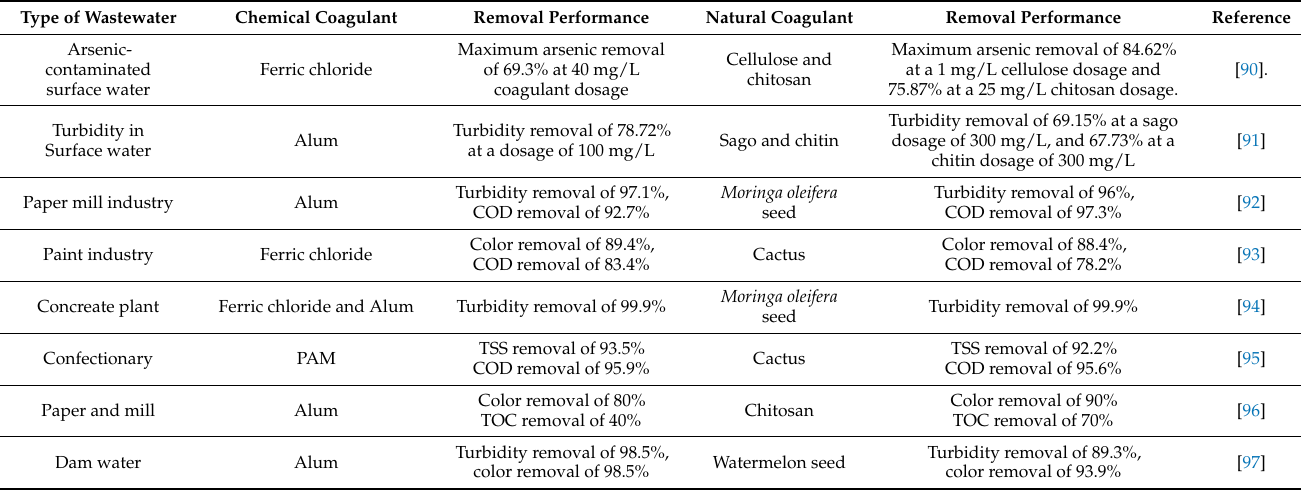
Table 3. Comparison performance of natural and chemical